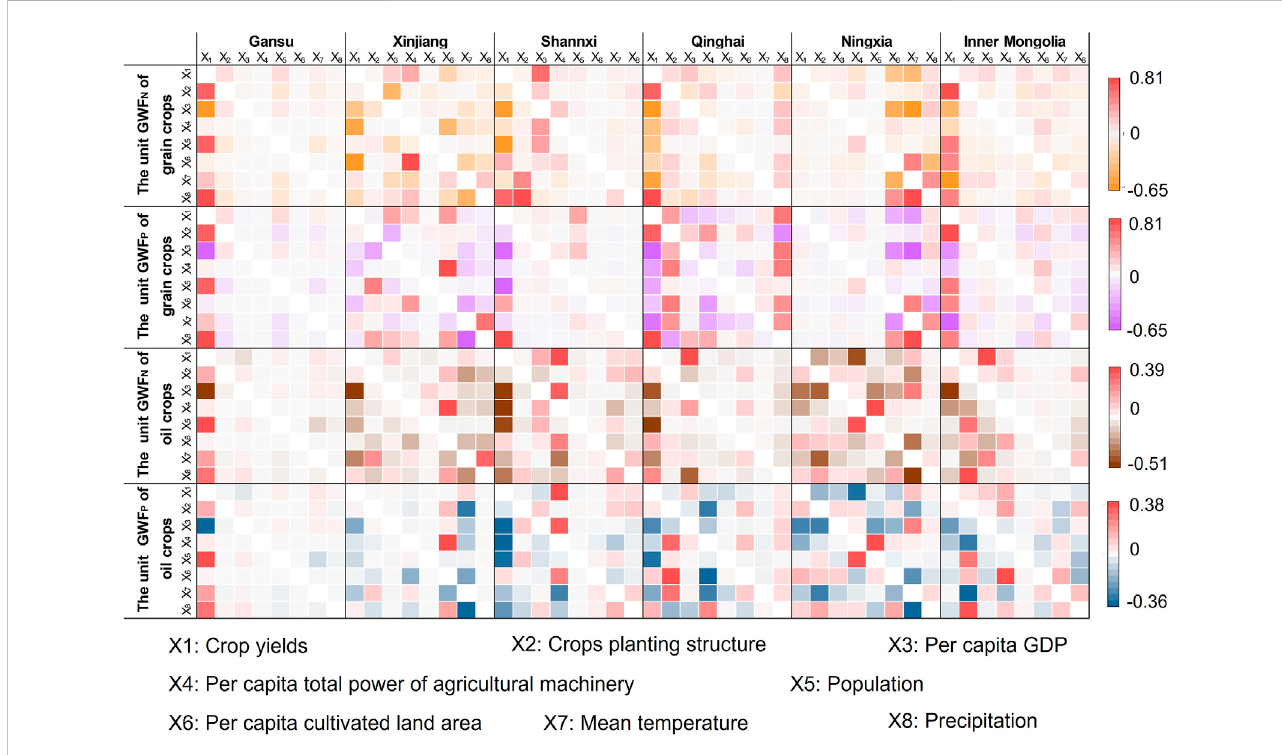
FIGURE 9 Indirect effects of various factors on the unit GWF of grain crops and oil crops in the six western provinces.